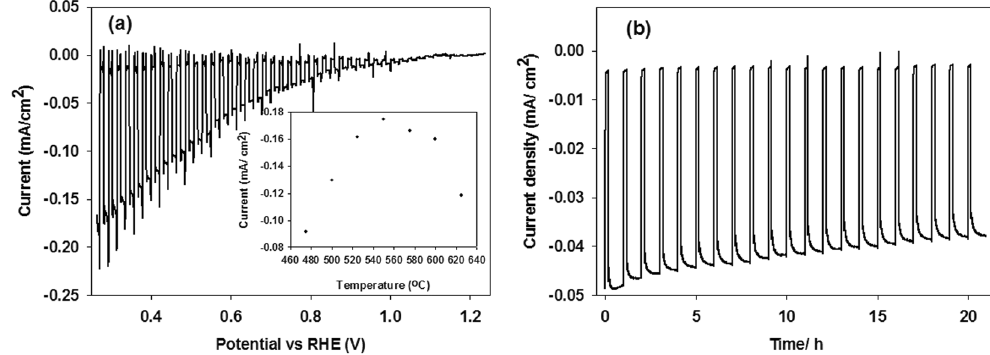
Figure 3. ( a ) J-V characteristics of LaFeO 3 under chopped illumination in a 0.1 M pH 13 electrolyte. ( b ) Chronoamperometry test of